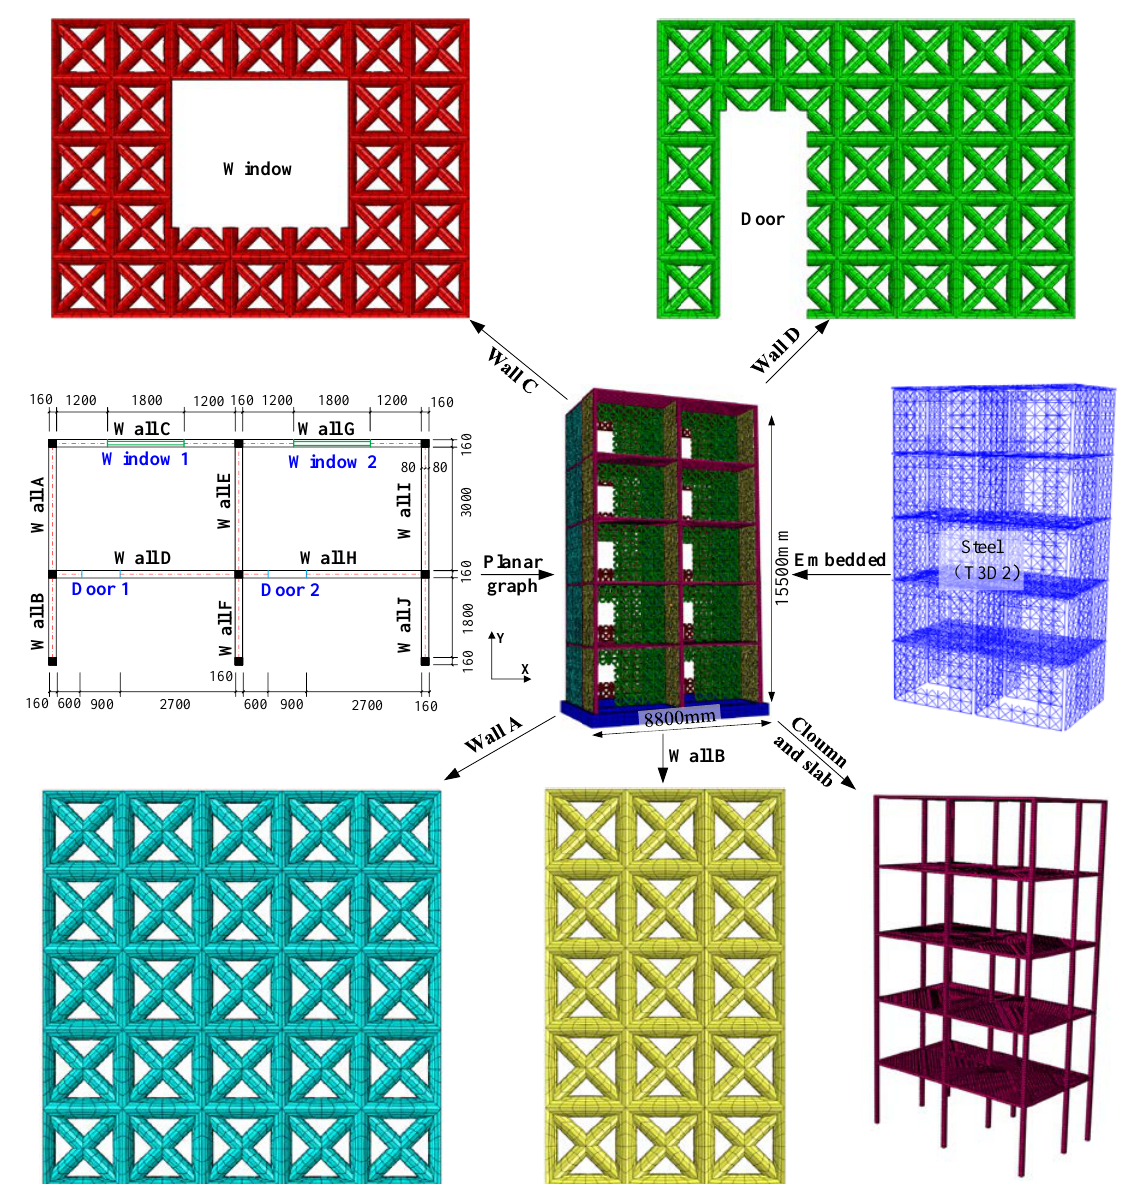
Figure 4. Finite element meshes of the star-type grid concrete wall structure (unit: mm).